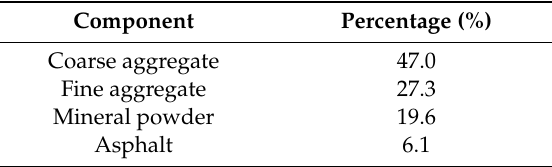
Table 1. Percentage shares of all components for the Gussasphalt (GA) mixture.